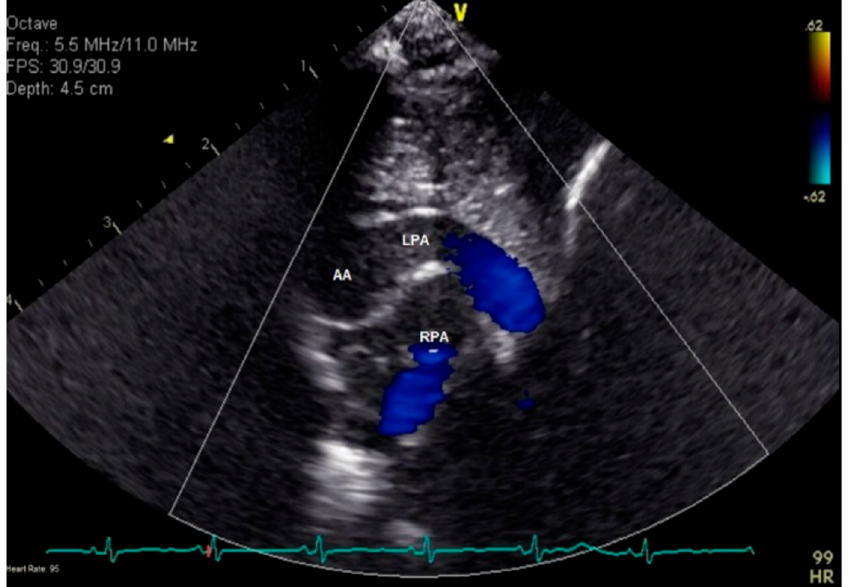
Figure 3. Echocardiography in the high-right parasternal short-axis view in a more superior plane than Figure 2. Color interrogation at this level demonstrates a vessel arising from the anterior aspect of the ascending aorta and then coursing leftward, passing over the pulmonary trunk and the right pulmonary artery.